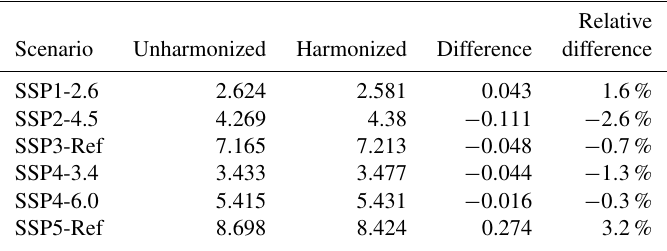
Table B3. EOC RF values for unharmonized and harmonized scenario results and differences between the two. The ScenarioMIP design (O’Neill et al., 2016) states that absolute differences must be within ± 0 . 75Wm − 2 , for which all scenarios fall well within the acceptable